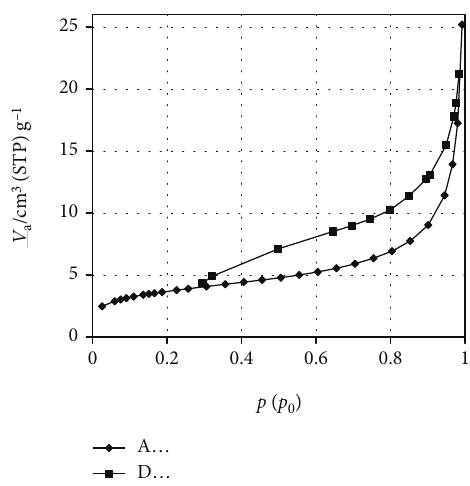
Figure 2: N gas adsorption-desorption isotherms for GC at 77 K. 2